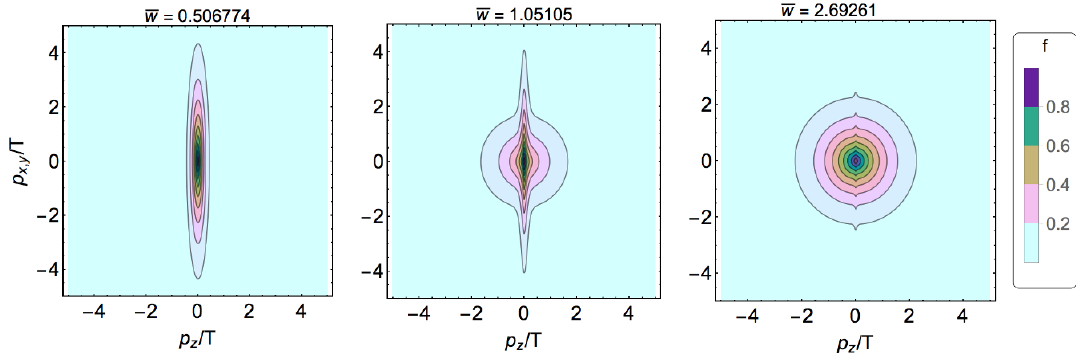
Figure 2 . Visualization of the one-particle distribution function obtained using a typical (non- attractor) anisotropic initial condition.